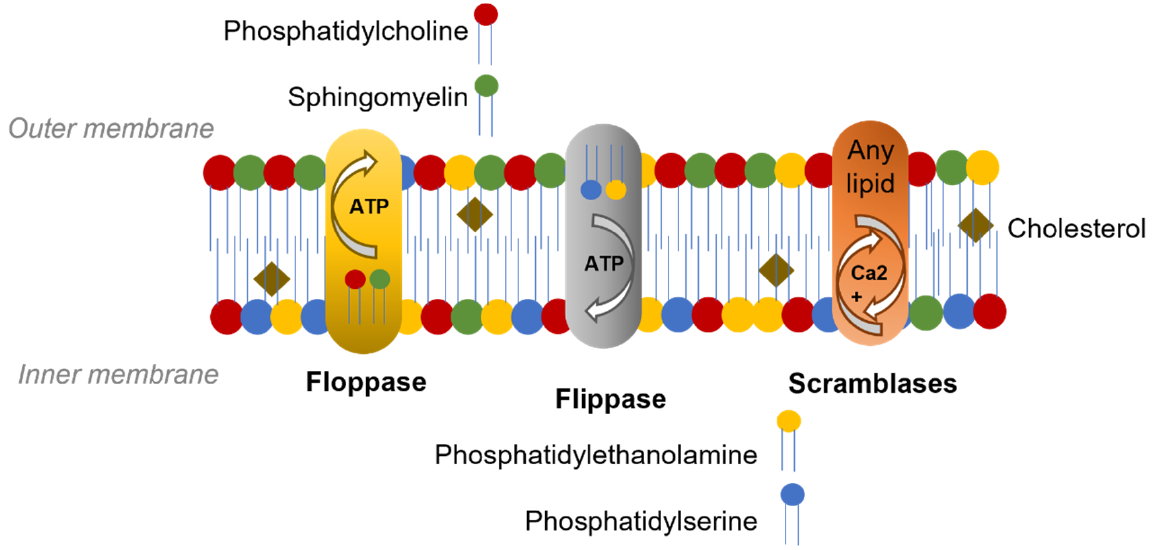
Figure 1. Phospholipids distribution in the RBC membrane. The phospholipids in the RBC mem- brane have an asymmetric distribution while cholesterol is evenly arranged. Phospholipid location is maintained by the ATP-dependent translocases, flippases transport phosphatidylserine and phos- phatidylethanolamine, from the outer to the inner monolayer and floppases transport phosphatidyl- choline and sphingomyelin from the inner to the outer monolayer. The Ca 2+ -dependent scramblases can transport phospholipids in both directions.